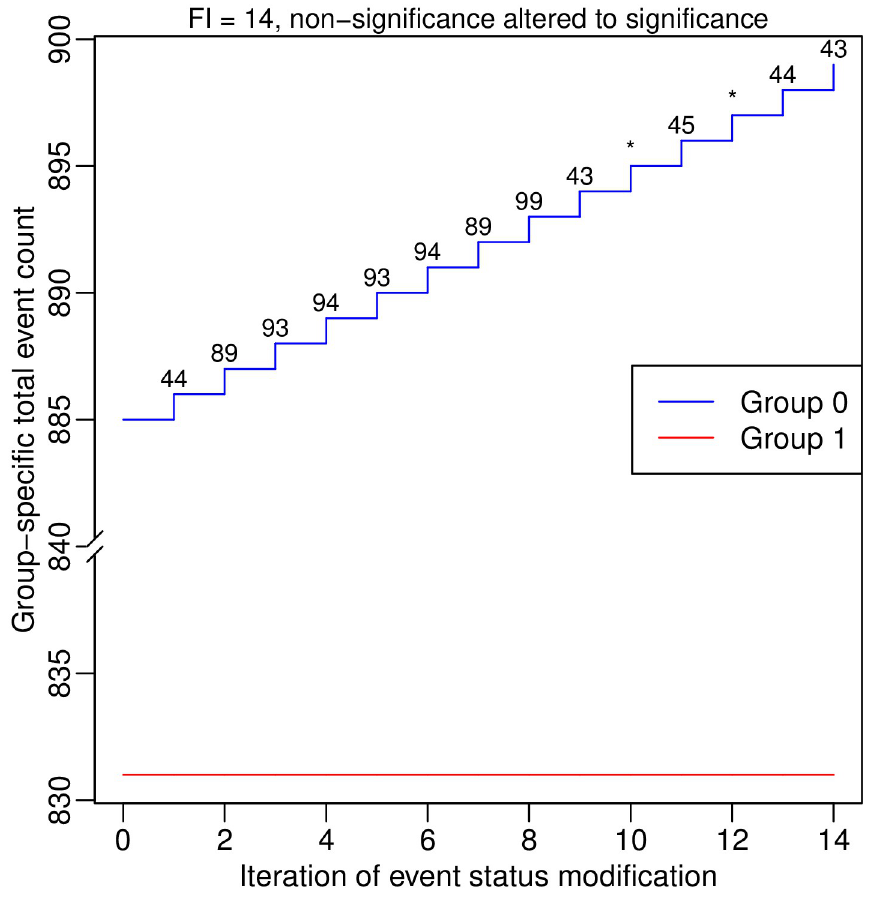
Fig 4. Event status modifications in the first pairwise meta-analysis in the dataset dat.ns . Each line represents changes in the total event count in a certain group. The numbers around each line indicate the studies involved in the event status modifications during the iterations; each asterisk indicates that a study remains unchanged as in the previous iteration.